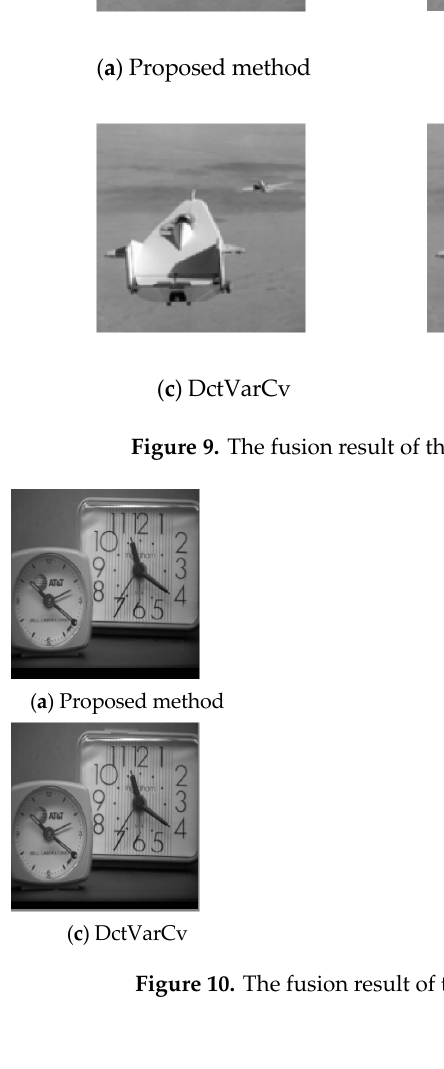
( d ) SAIF Figure 11. The fusion result of the clock image. ( a ) Proposed method ( d ) SAIF Figure 12. The fusion result of the lab image.